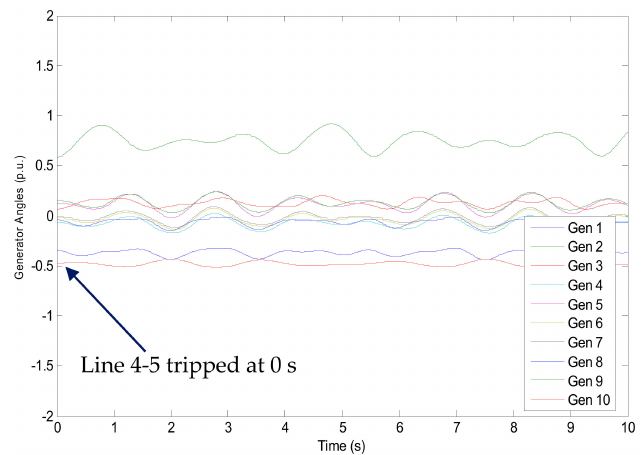
Figure 5. Transiently stable case after Line 4–5 was